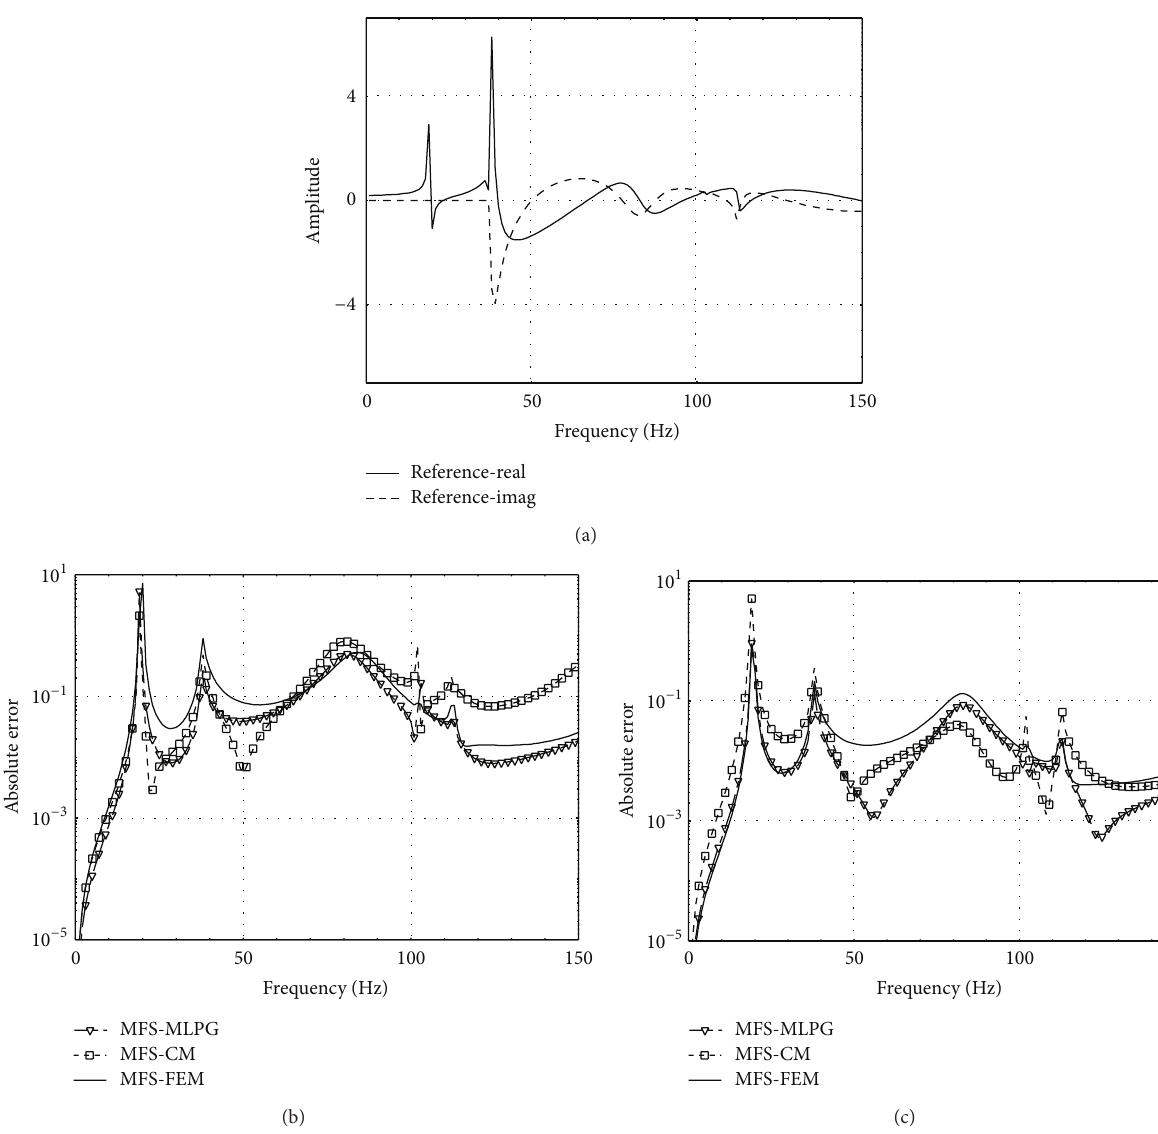
Figure 16: (a) Reference pressure result; absolute error considering (b) 20 and (c) 40 boundary nodes in the solid, along the solid-fluid